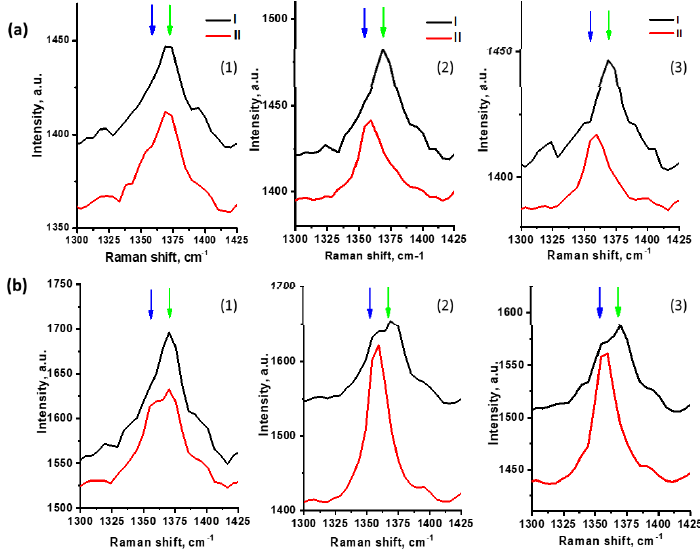
Figure 4. Characteristic Raman spectra of individual RBCs extended in the 1300–1425 cm − 1 range. Examples for ( a ) the most oxygenated RBCs; and ( b ) the most deoxygenated RBCs. For every RBC, the spectra demonstrate the higher (I) and lower (II) oxygenation states. (1) Control RBC; (2) RBC treated with TiO 2 (r); and (3) RBC treated with TiO 2 (a). Blue and green arrows mark the ν 4 band at 1356 cm − 1 and 1372 cm − 1 ,